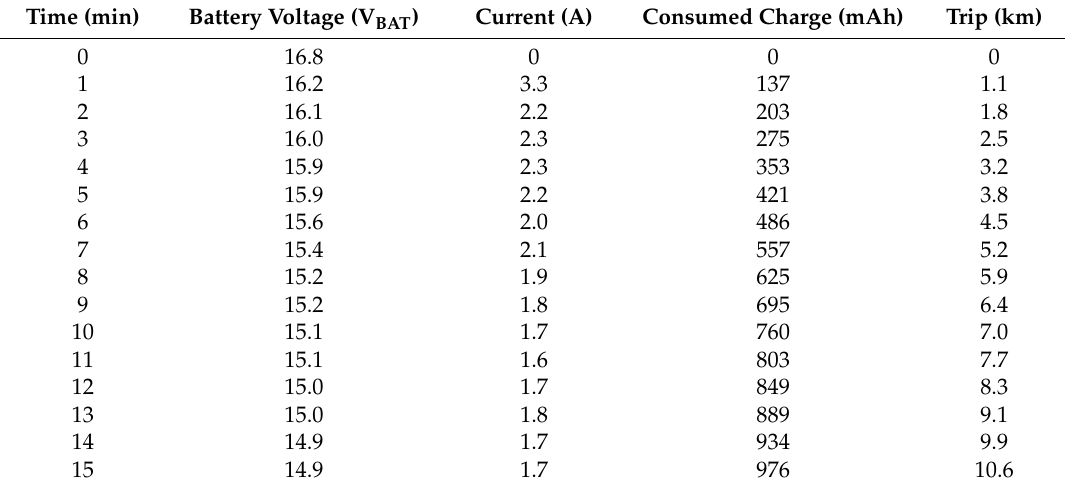
Table 1. Data collected for the test of the airplane model without a PV system (air density ρ = 1.174 kg/m 3 ).